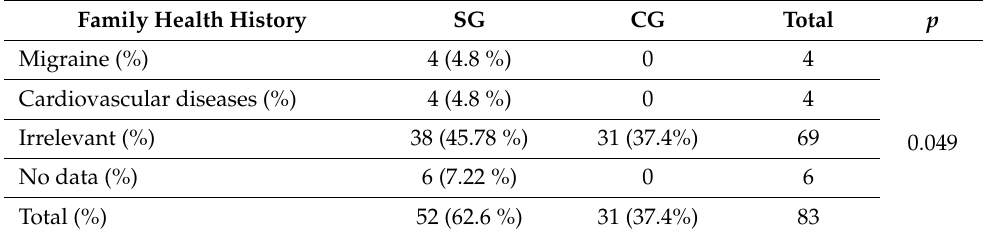
Table 2. Characteristics of a family health history in the study group (SG) and control group